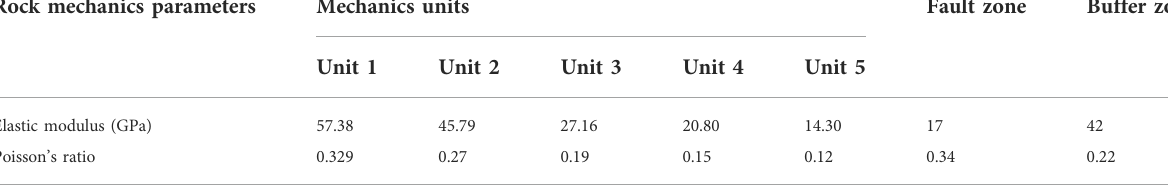
TABLE 1 Rock mechanical properties of shale in Lintanchang area of eastern Sichuan